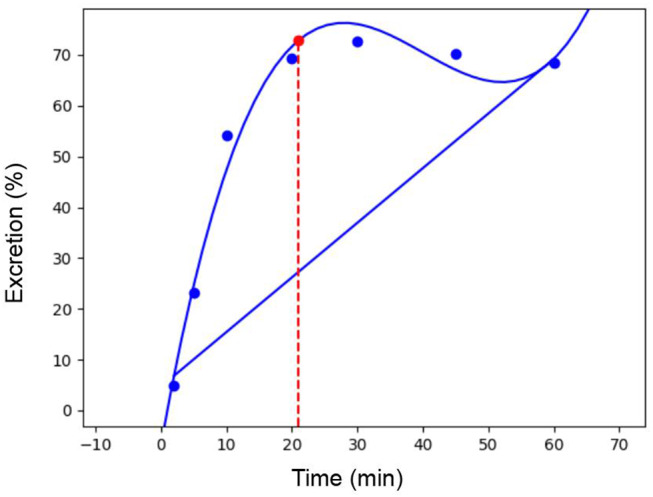
Elimination of ingested 13C labeled bicarbonate.